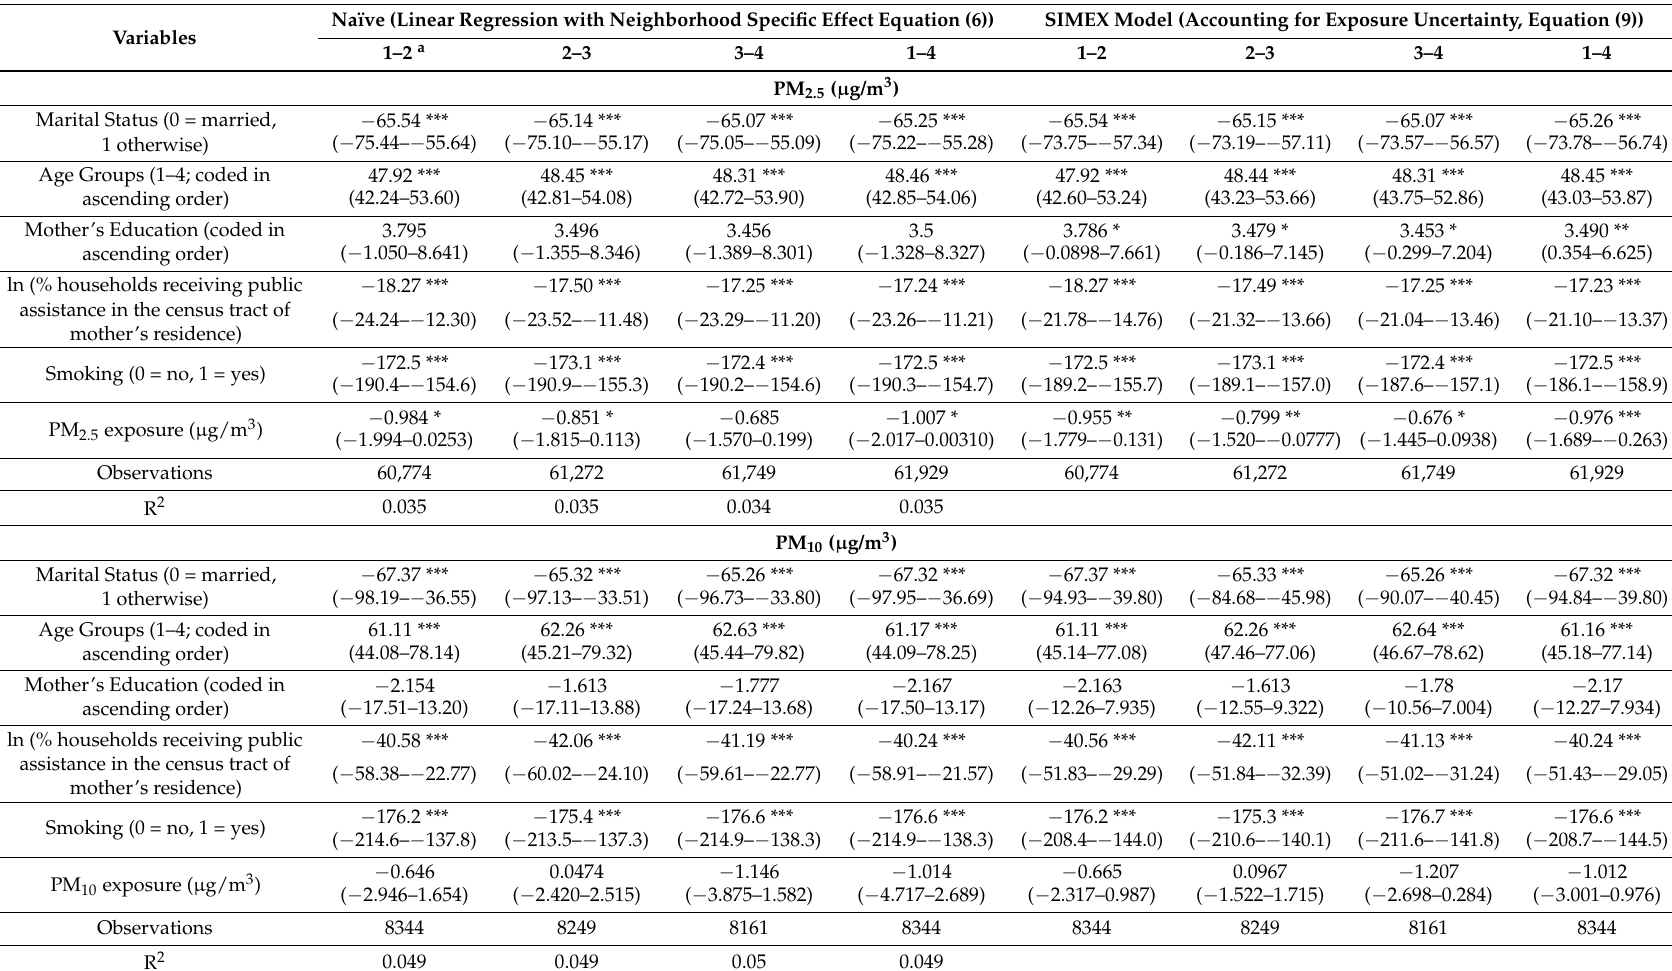
Table 4. Linear regression of BW (g) with respect PM exposure in Chicago, 2000–2004 without and with the exposure measurement